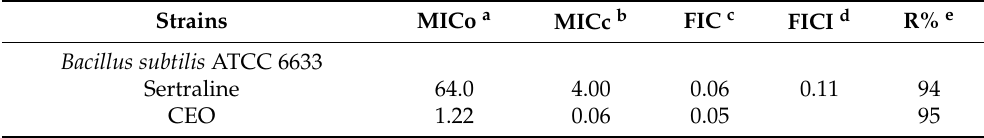
Table 2. Antibacterial activity of sertraline ( µ g/mL), Cinnamomum verum EO (mg/mL), and their combination on different bacterial